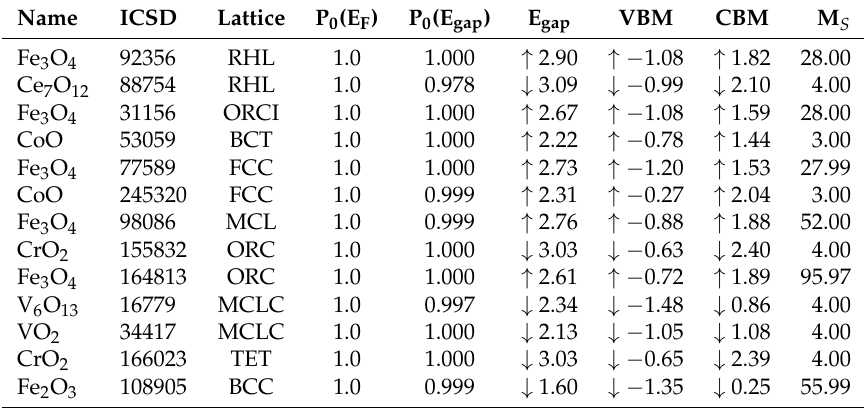
Table A1. Binary half-metallic oxides. P 0 (E F ) and P 0 (E gap ) denote spin polarization at the Fermi level and within the band gap, respectively. E gap , VBM, and CBM are calculated for the insulating channel either in spin majority or minority (identified by ↑ and ↓ ). M S refers to the saturation